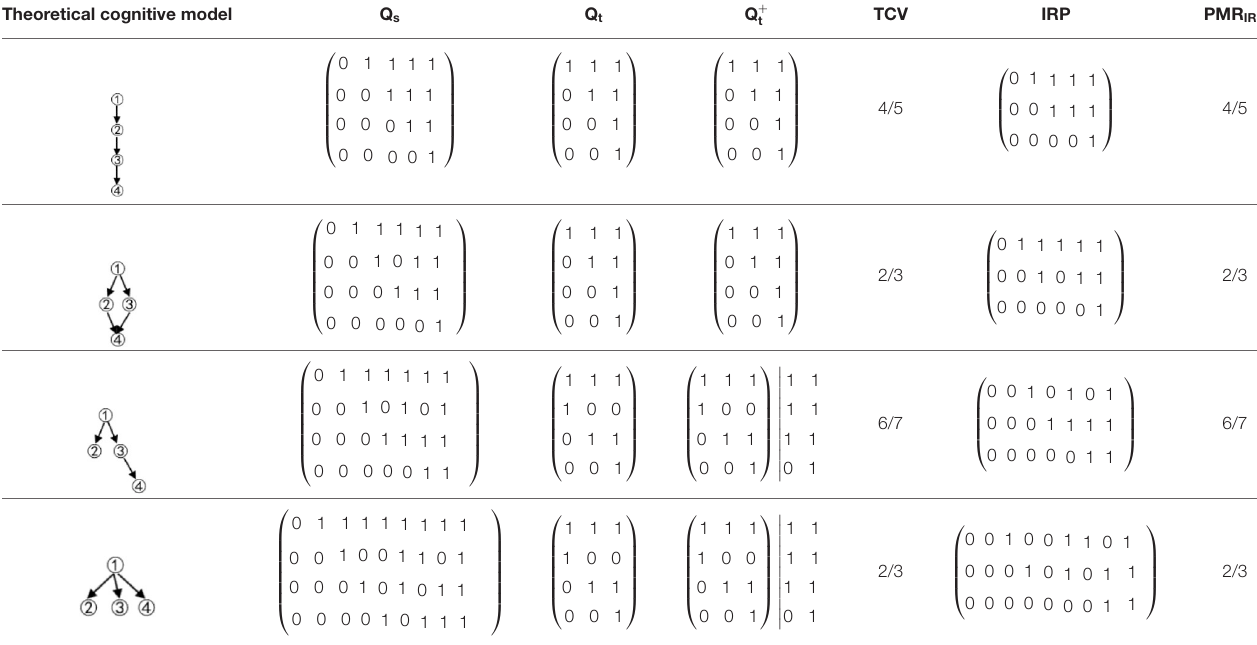
TABLE 1 | The relationships between the theoretical construct validity (TCV) and the PMR IRP of other structures. Theoretical cognitive